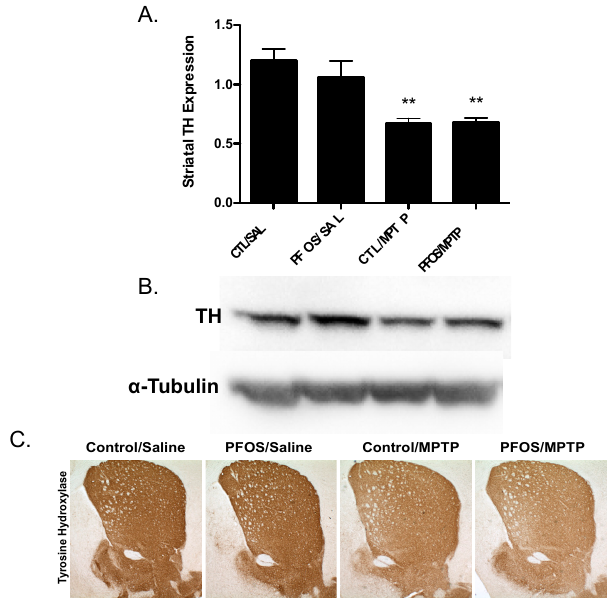
Figure 5. Challenge with the dopamine neurotoxin, MPTP, does not cause significant reductions in